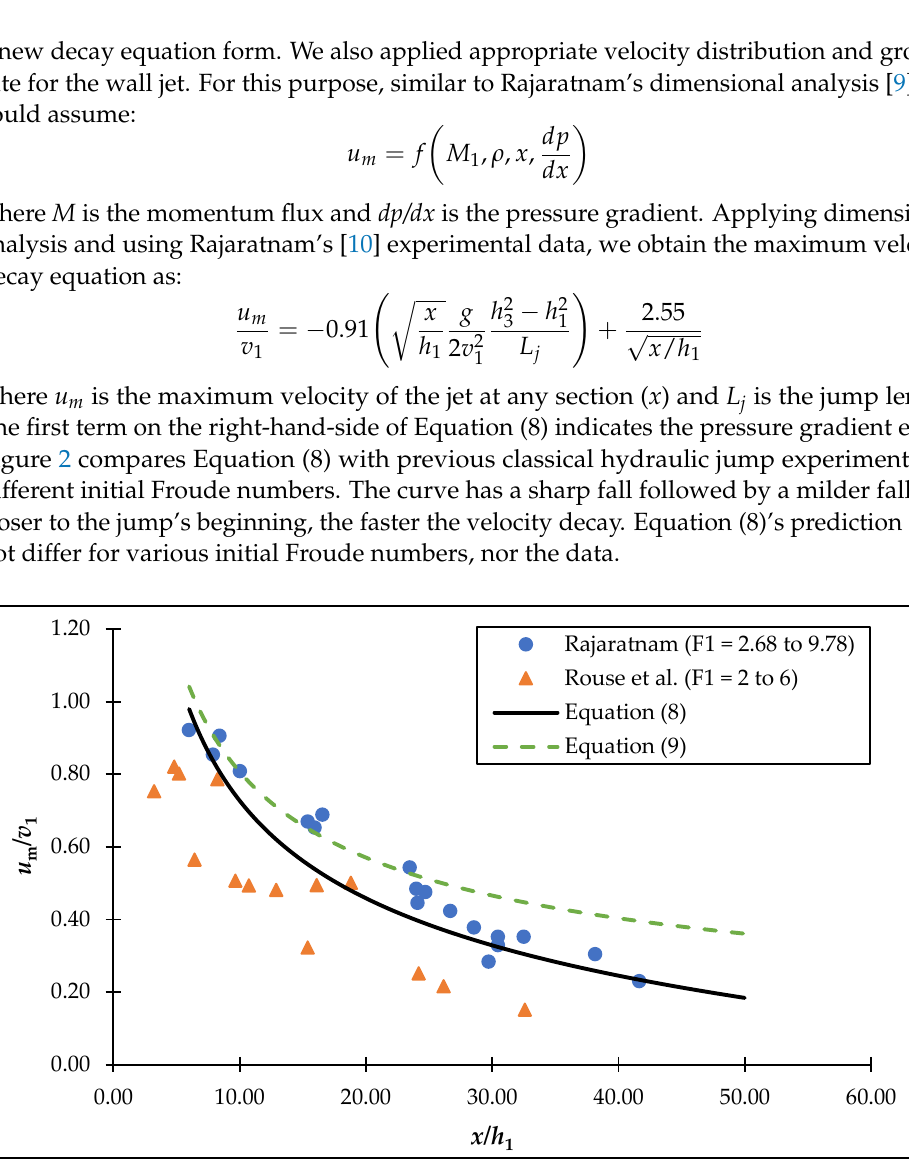
Figure 2. Maximum velocity decay for the hydraulic jump.